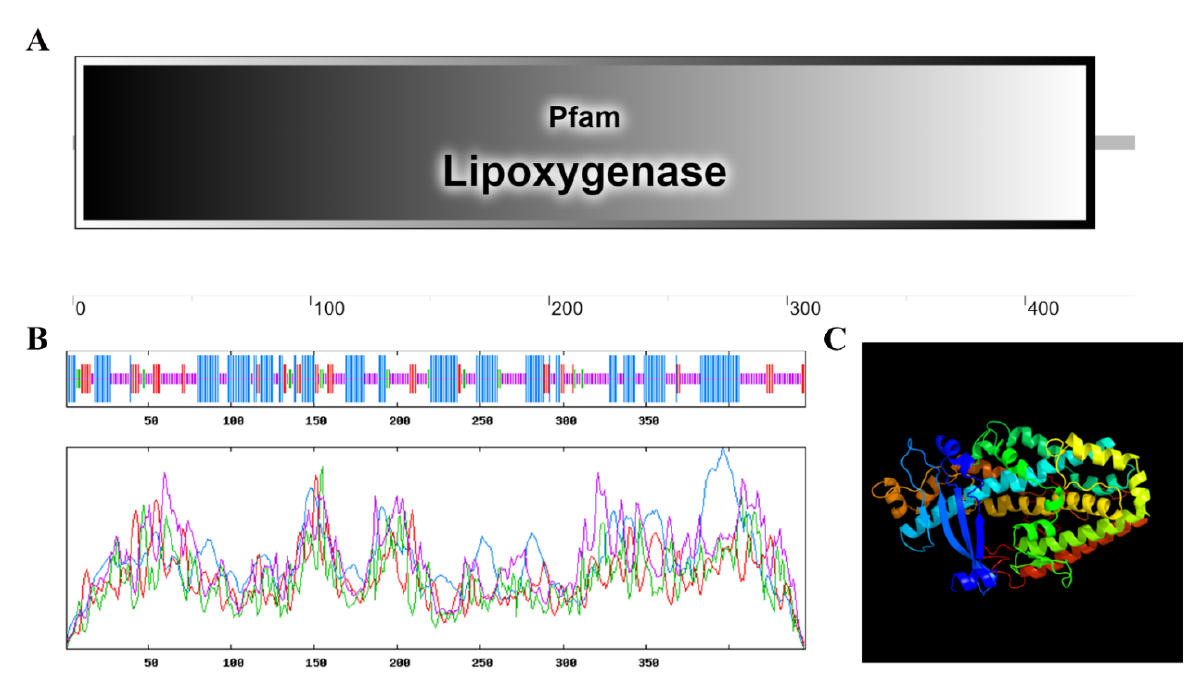
Figure 1. Bioinformatics analysis of the MdLOX3 gene. ( A ) Conserved domain of MdLOX3 protein. The rectangle indicates the lipoxygenase domain. The numbers represent the length of amino acids. The predicted secondary ( B ) and tertiary ( C ) protein structures of MdLOX3. The numbers denote the length of amino acids. Blue, red, orange and green represent alpha helices, extended strands, random coils and beta turns.